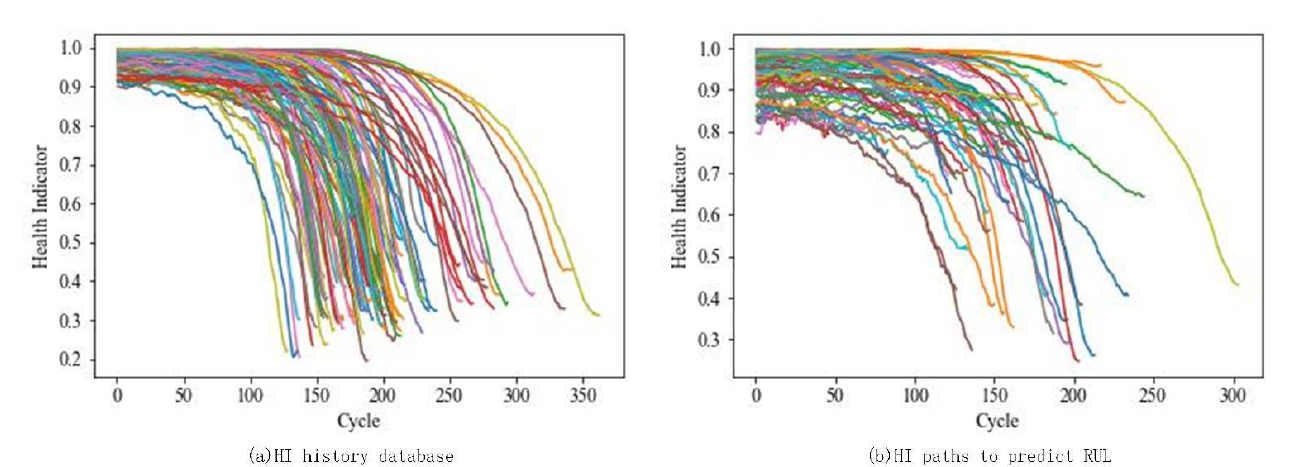
Figure 14. HI degradation trajectory.